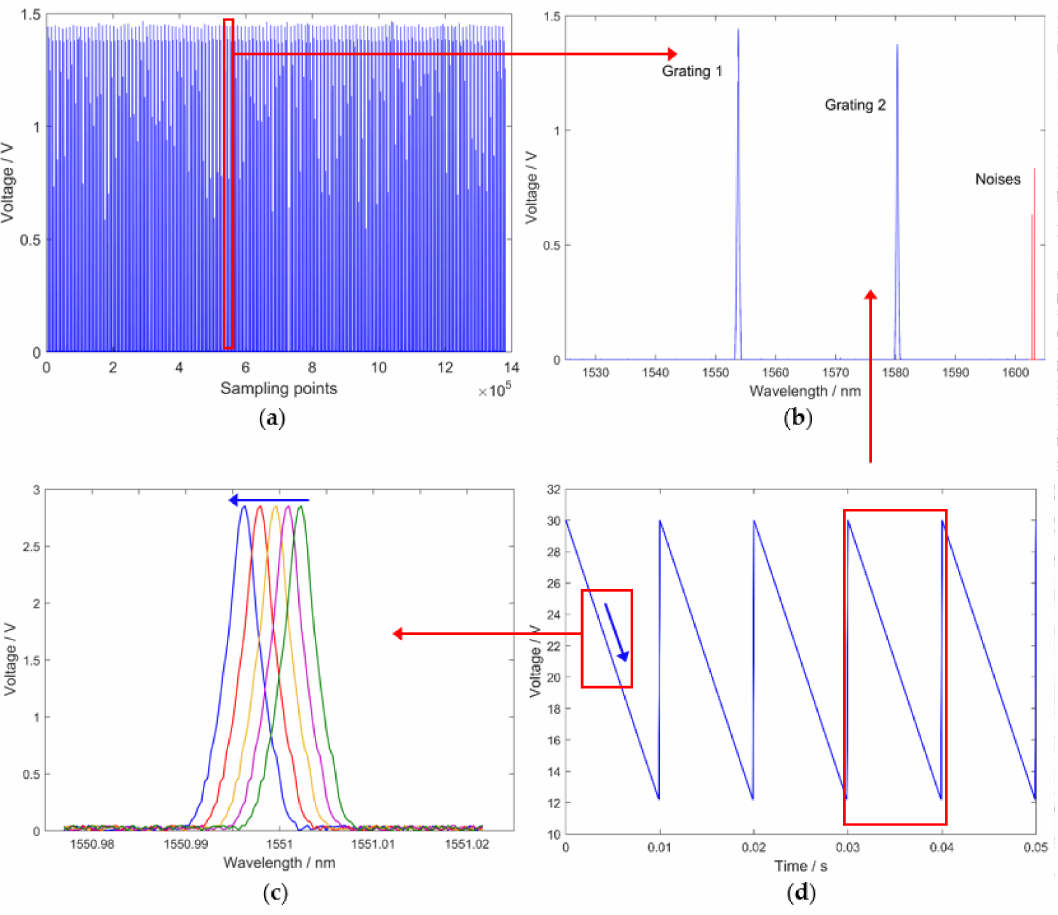
Figure 2. The relationship between key signals: ( a ) the reflection spectrum of the FBG sensor; ( b ) one period waveform of ( a ); ( c ) the output of the F–P filter (different color lines express the corresponding wavelengths when the voltage changes); and ( d ) the 12–30 V ramp scanning voltage